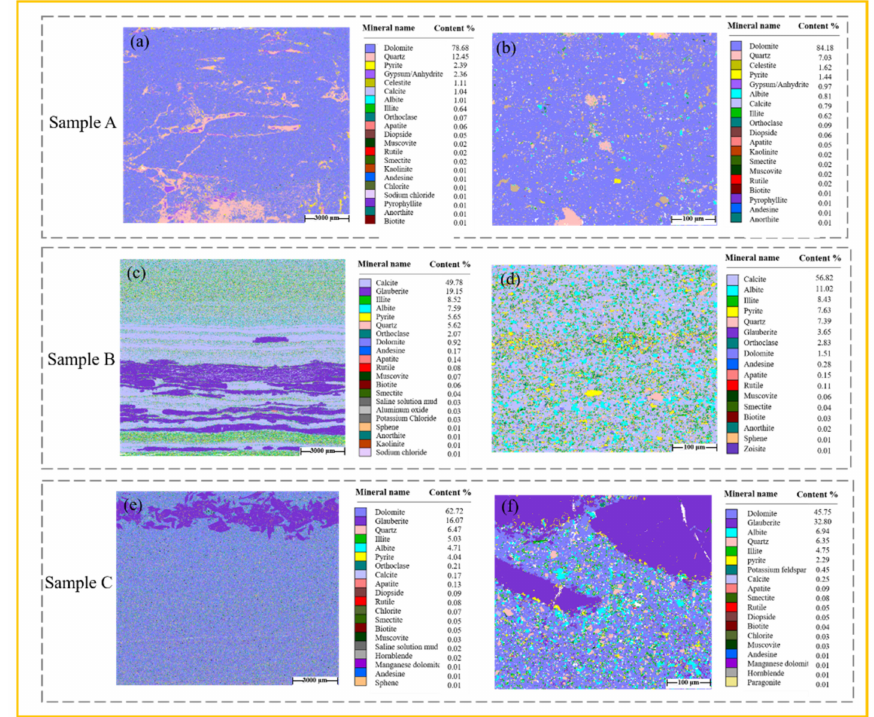
Figure 4. QEMSCAN crude ( a , c , e ) and fine ( b , d , f ) scanning test results of sample A, sample B, and sample